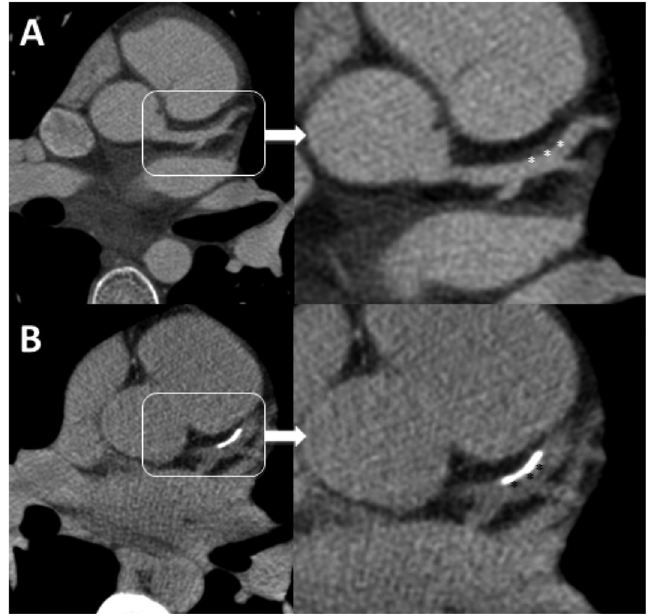
Figure 7. Progression of plaque. A) Initial coronary CT demonstrates subtle soft plaque/vessel wall thickening (white asterisks) in the proximal LAD. B) Calcium score, 3 years later, now shows new overlying calcification (black asterisks) implying mineralization secondary to chronic low-grade inflammation. Statin therapy should be consid- ered for all KD patients although the level of evidence for treatment is